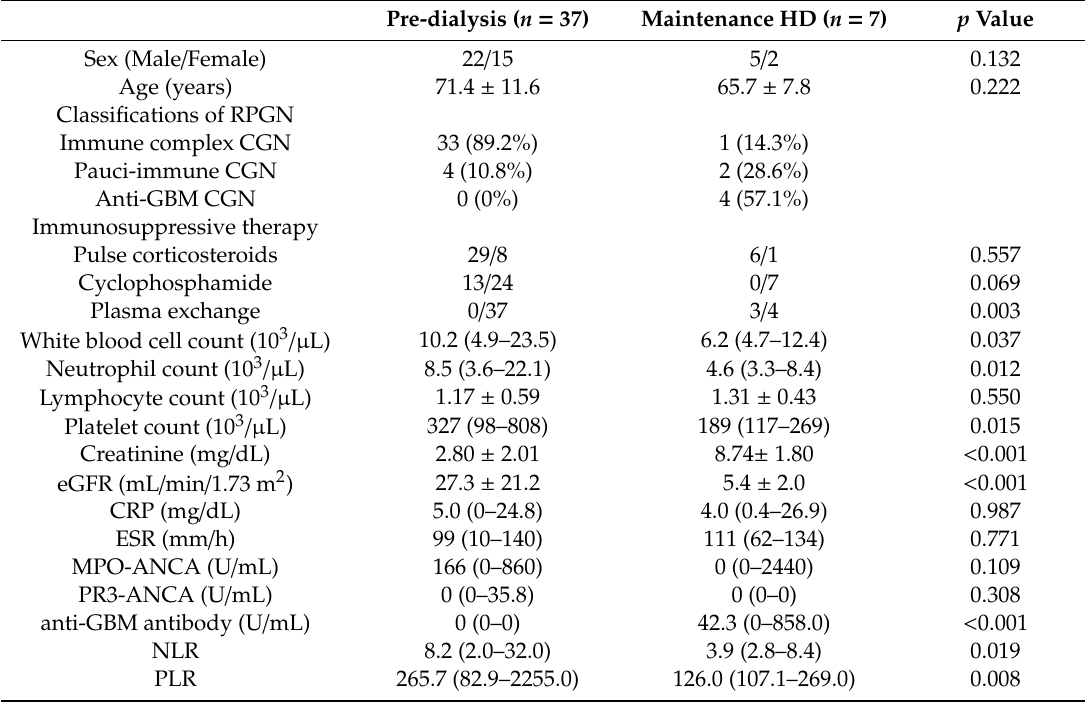
Table 1. Patient’s characteristics between the pre-dialysis and maintenance hemodialysis (HD) groups.